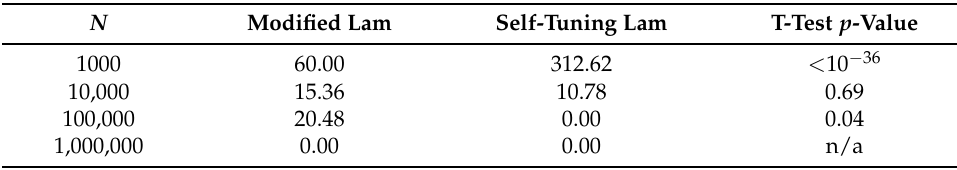
Table 5. Average solution cost for the TwoMax problem. N Modified Lam Self-Tuning Lam T-Test p